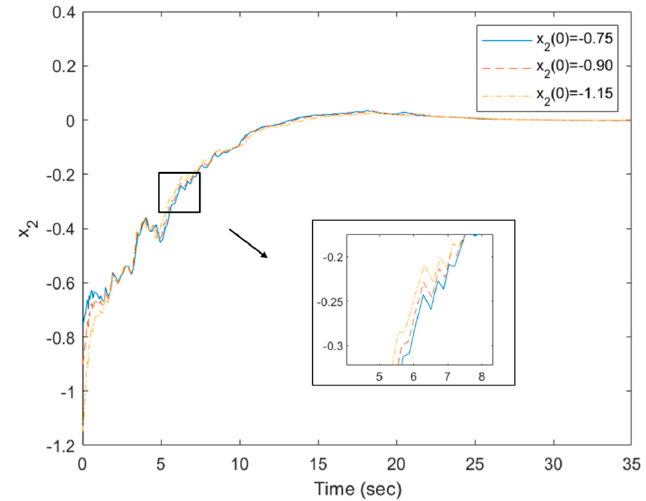
Figure 3. Response of 𝑥 (cid:2870) (cid:4666)𝑡(cid:4667) .